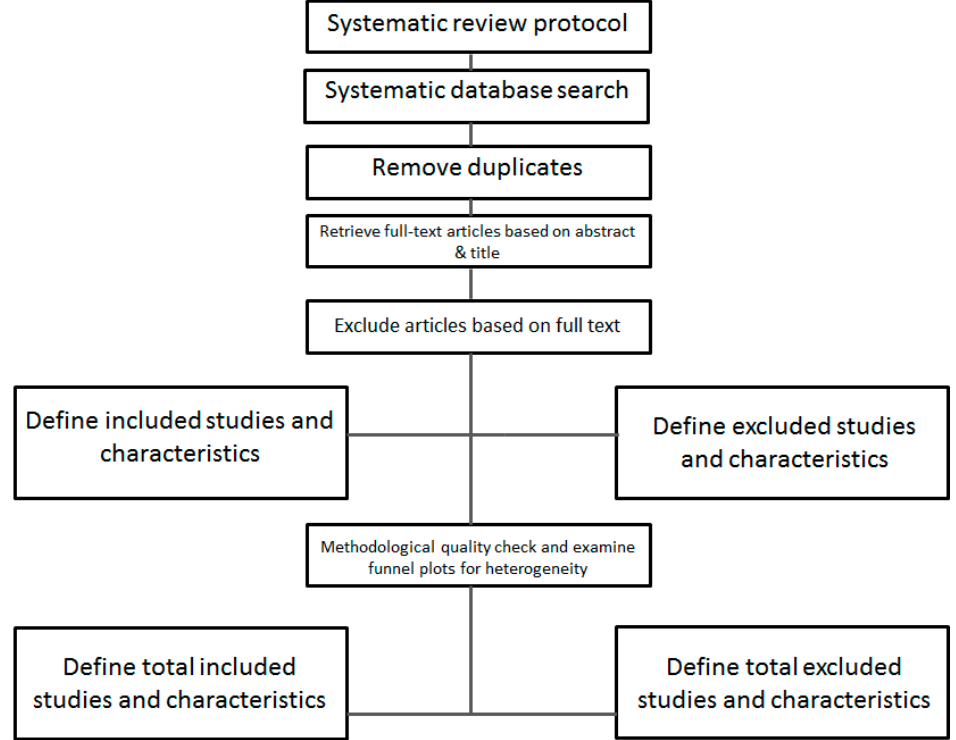
Figure 1. Systematic review flow chart.